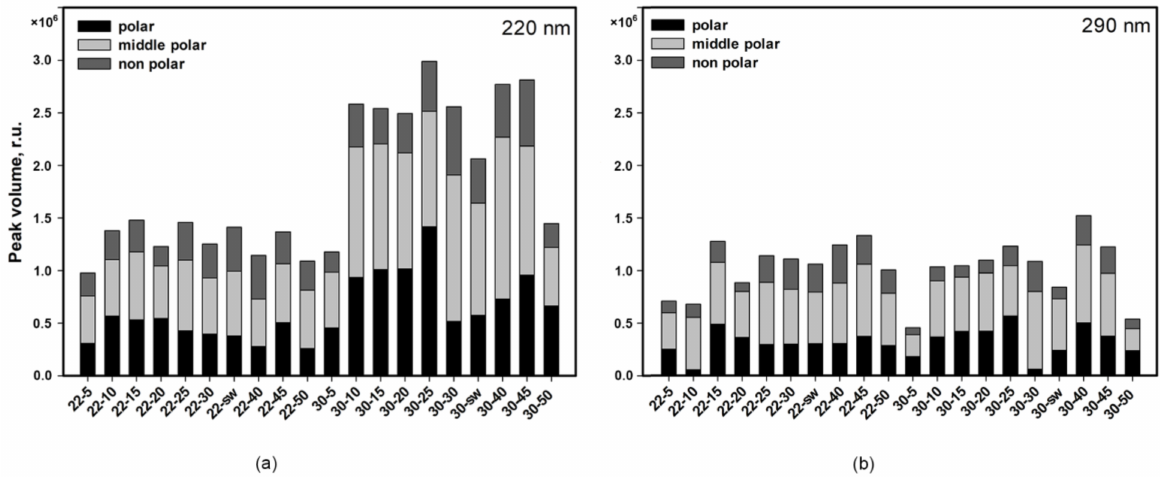
Figure 3. Total area of peaks in HPLC UV chromatograms. ( a ) Detection at 220 nm; ( b ) detection at 290 nm. The codes of extracts are presented in X axes of